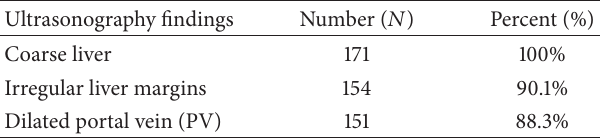
Table 4: Number of patients having different detectable liver abnormalities on an abdominal ultrasound.